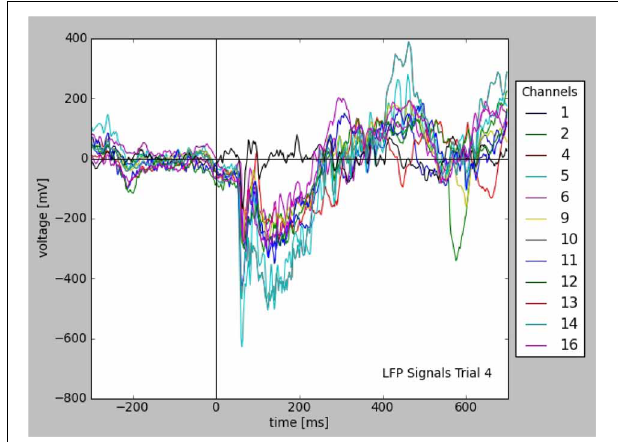
FIGURE 2 | Plot of LFP responses from a trial that was selected for a given stimulus configuration (see text). Note that the information used for axes, labels, and legend was taken from the stored data and metadata